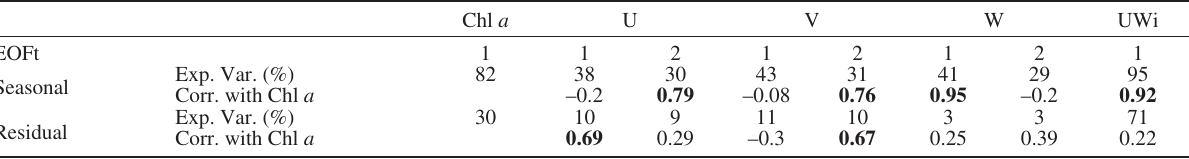
Table 1. – Seasonal and residual EOFts of explained variance (Exp. Var.) of Chl a , zonal wind and velocity components and correlation between Chl a and velocity components and zonal wind seasonally shifted for 90 days and the non-shifted wind residual. The correlations over 0.5 are highlighted in